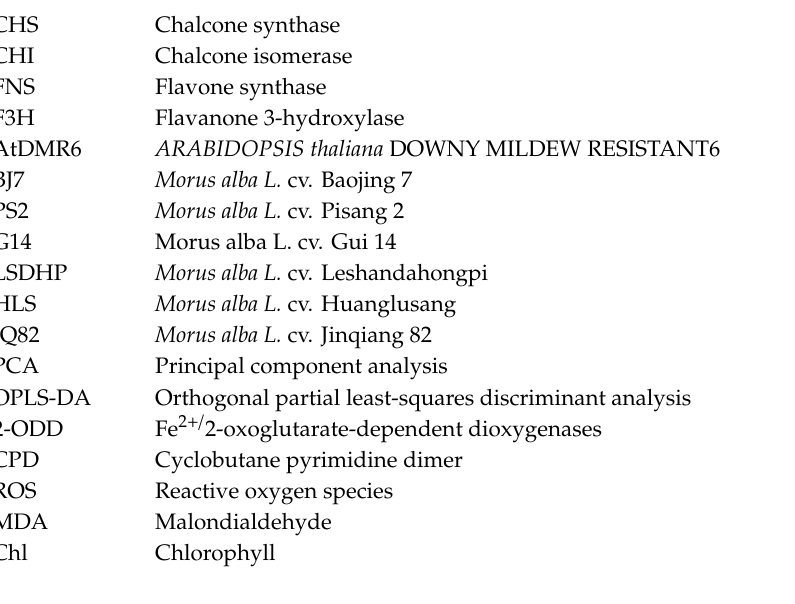
Figure S1: OPLS-DA score plots between di ff erent mulberry cultivars. Figure S2: Expression of MnFNSI and MnF3H in Escherichia coli . Figure S3. Flavone contents in leaves of wild-type and transgenic tobacco plants. Table S1: Qualitative and quantitative results for metabolites in leaves of BJ7, G14, PS2, HLS, JQ82, and LSDHP. Table S2. Quantitative results for flavonoids of BJ7, G14, PS2, HLS, JQ82, and LSDHP leaves. Table S3: Di ff erentially accumulated metabolites between HLS and BJ7. Table S4: Di ff erentially accumulated metabolites between HLS and G14. Table S5: Di ff erentially accumulated metabolites between HLS and PS2. Table S6: Di ff erentially accumulated metabolites between JQ82 and BJ7. Table S7: Di ff erentially accumulated metabolites between JQ82 and G14. Table S8: Di ff erentially accumulated metabolites between JQ82 and PS2. Table S9: Di ff erentially accumulated metabolites between LSDHP and BJ7. Table S10: Di ff erentially accumulated metabolites between LSDHP and G14. Table S11: Di ff erentially accumulated metabolites between LSDHP and PS2. Table S12: Flavonoids content in M. notabilis leaves. Table S13. Primers used in this study. Table S14. Accession numbers of sequences used in this